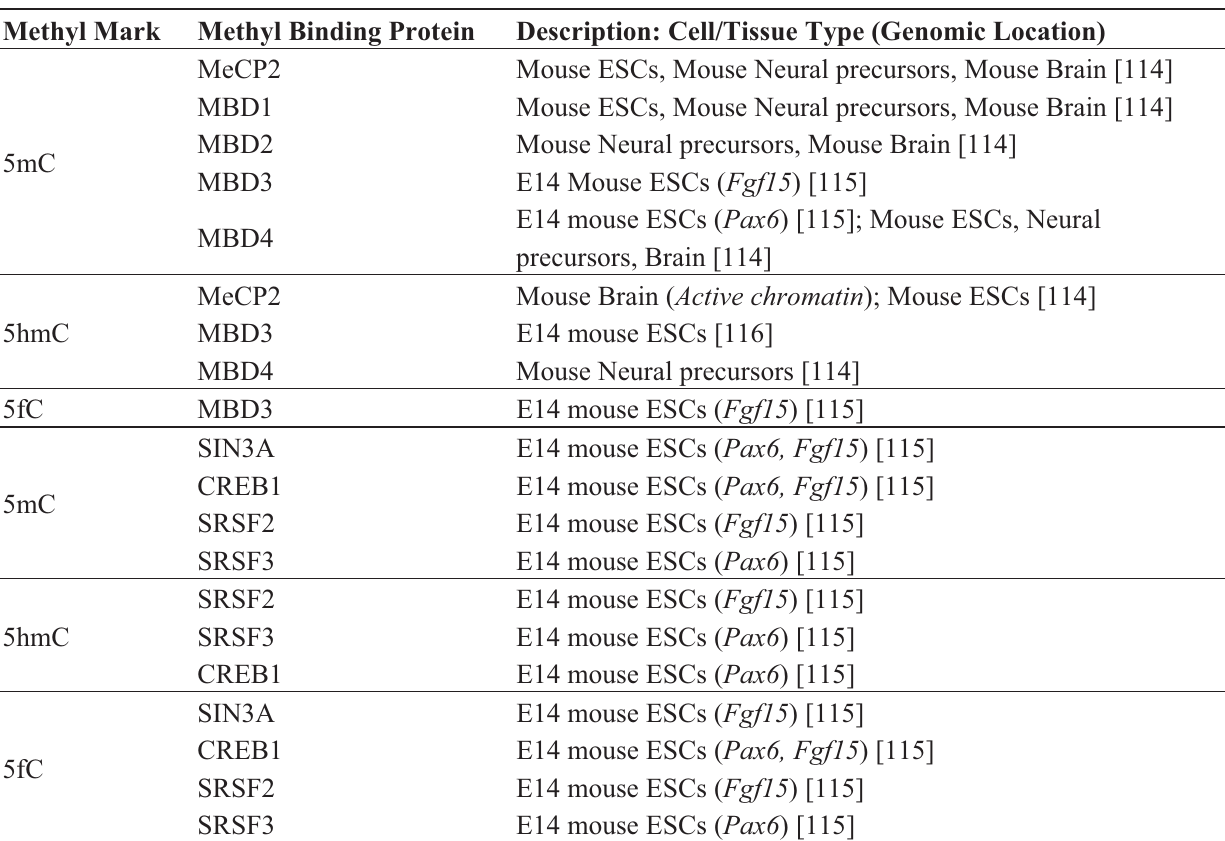
Table 1. Examples of proteins, which bind to methyl